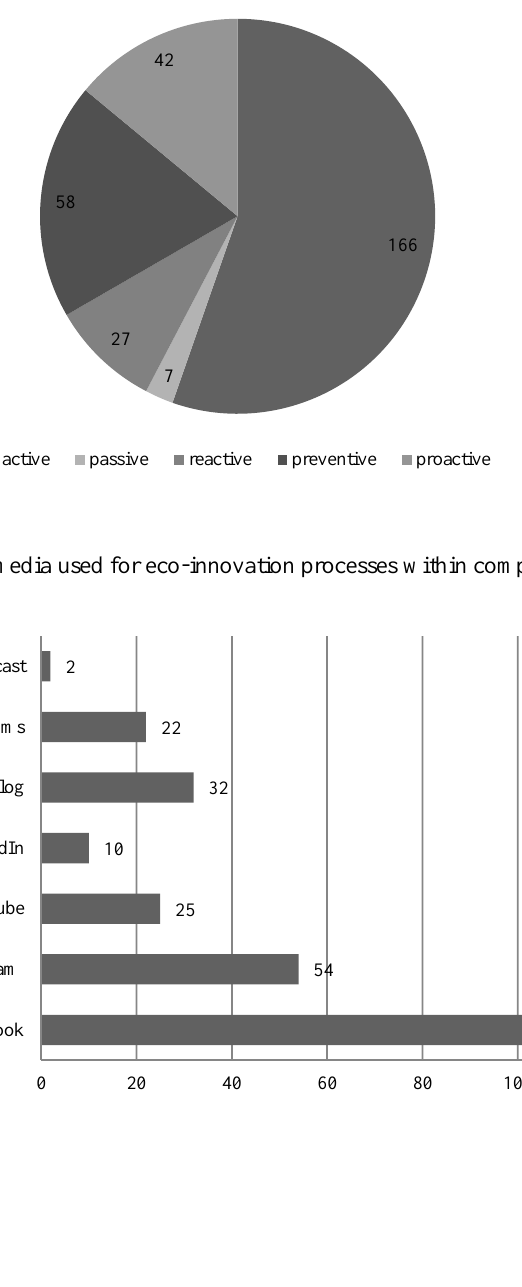
Figure 1. What is your company approach to environmental protection?